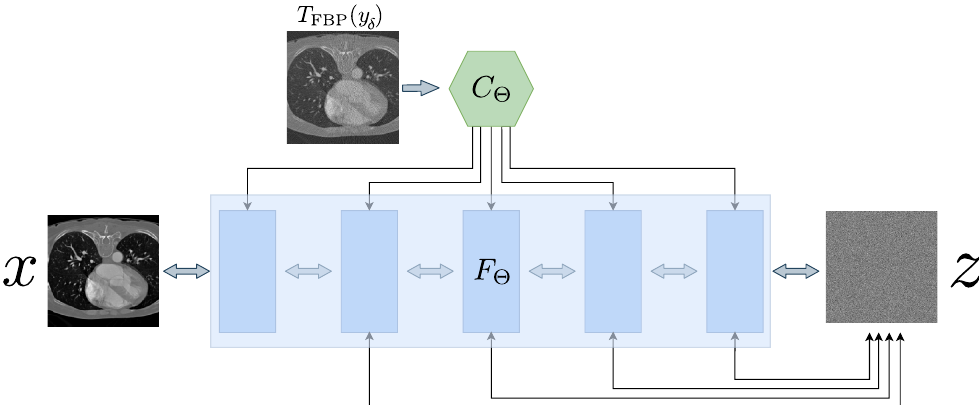
Figure A4. Architecture of the conditional invertible neural network. The ground truth image x is transformed by F Θ to a Gaussian distributed z . Adapted from